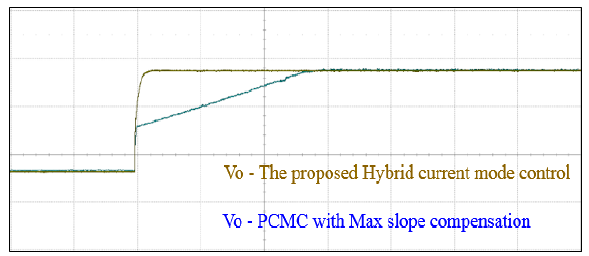
Figure 21. A waveform that implements a digital controller.